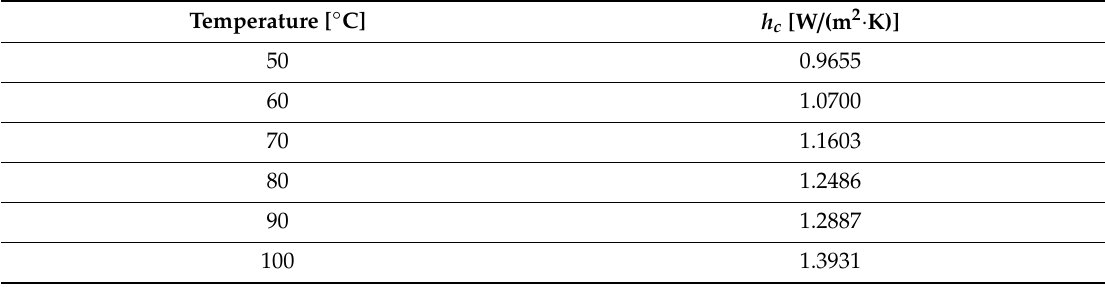
Table 4. Convective heat transfer coe ffi cient obtained with the